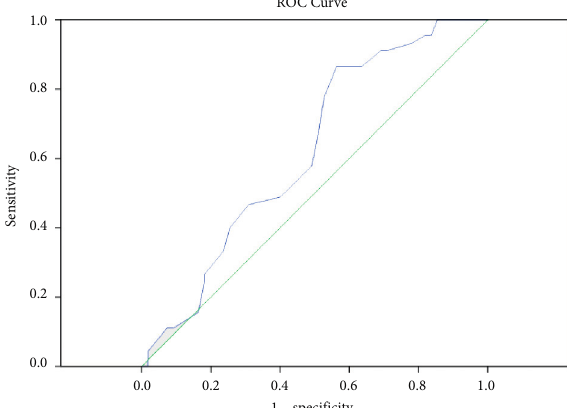
Figure 2: ROC curve having AUC 0.623 with a cut-off value of serum albumin ( < 3.25g/dL) to predict a prolonged length of ICU stay ( ≥ 10 days). Table 5: Depiction of the multivariable logistic regression of the variables in the study to predict prolonged length of ICU stay. Variables